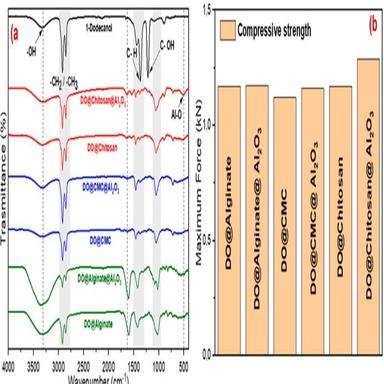
(a) FT-IR spectroscopy and (b) Compressive strength of EPCMs with and without nano-Al2O3.